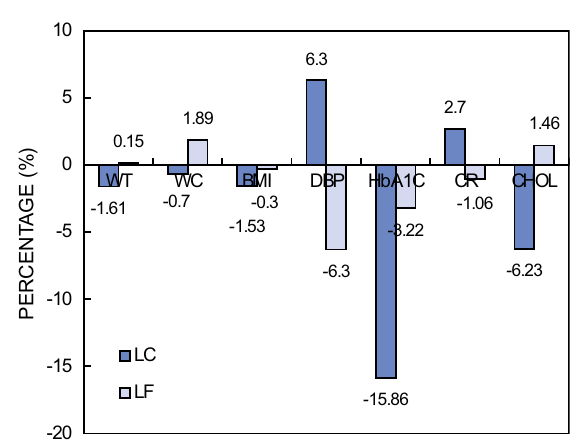
Figure 1: Percentage change after week 12 for the various